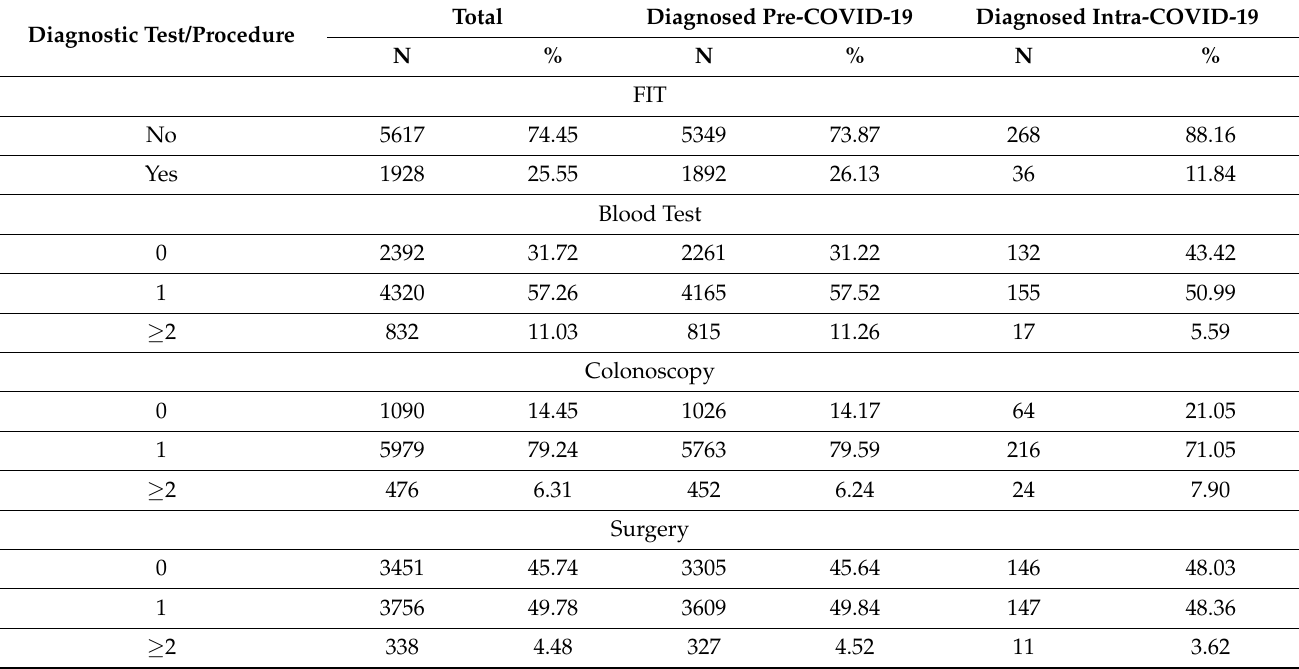
Table 2. Frequency and distribution of diagnostic milestones among 7545 patients diagnosed with colorectal cancer in Alberta, Canada between 1 January 2016 and 1 July 2020. Diagnostic